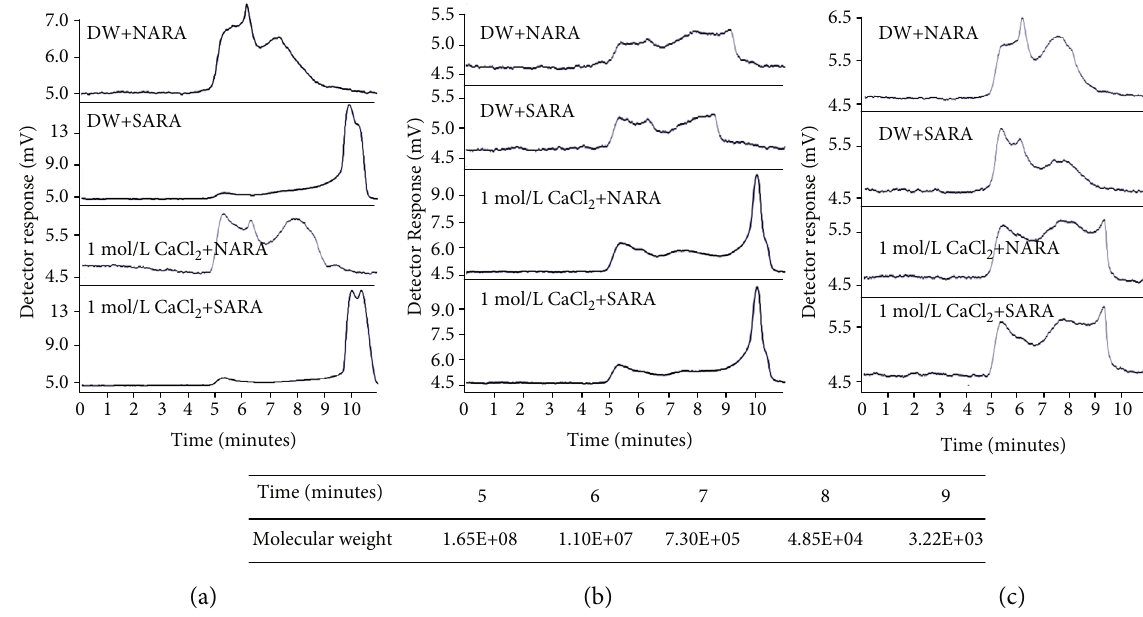
Figure 5: Molecular weight distribution. DW: distilled water; NARA: rice analogues with nonadditive; SARA: rice analogues containing sodium alginate. Adhesive layer. Escaping substances. Cooked rice